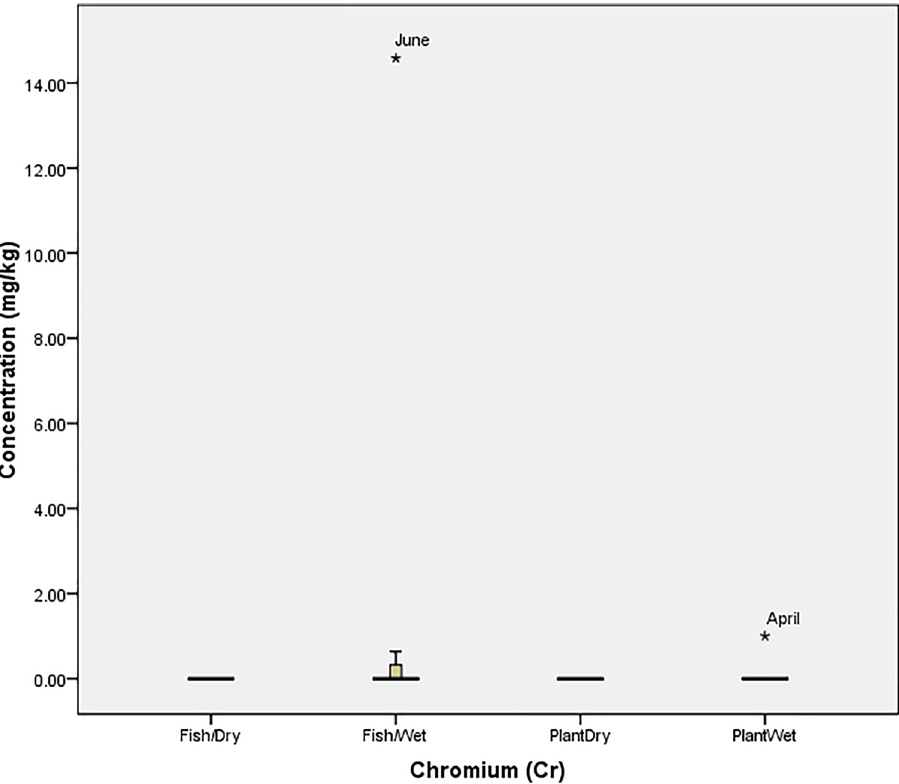
Figure 3. Tolerability of Chromium in O. niloticus (Fish) and I. aquatica (Plant) in Wet and Dry Seasons (Source: Field